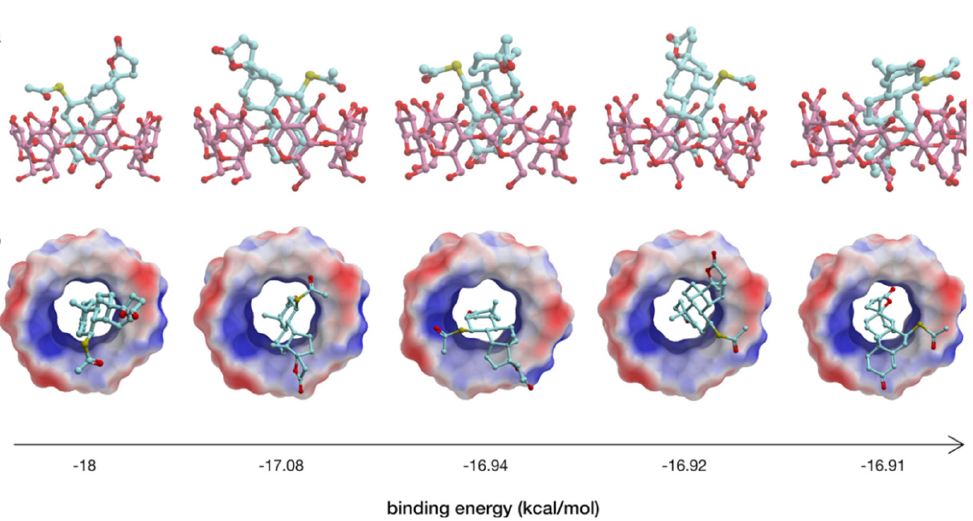
Figure 3. Docked conformations of SPL with HP- β -CyD. ( a ) Side view of the possible complexes formed between SPL (light blue) and HP- β -Cy (pink) and ( b ) top view of the complexes highlighting the electrostatic surface of HP- β -Cy. The binding energies (kcal/mol) are listed below the complexes.